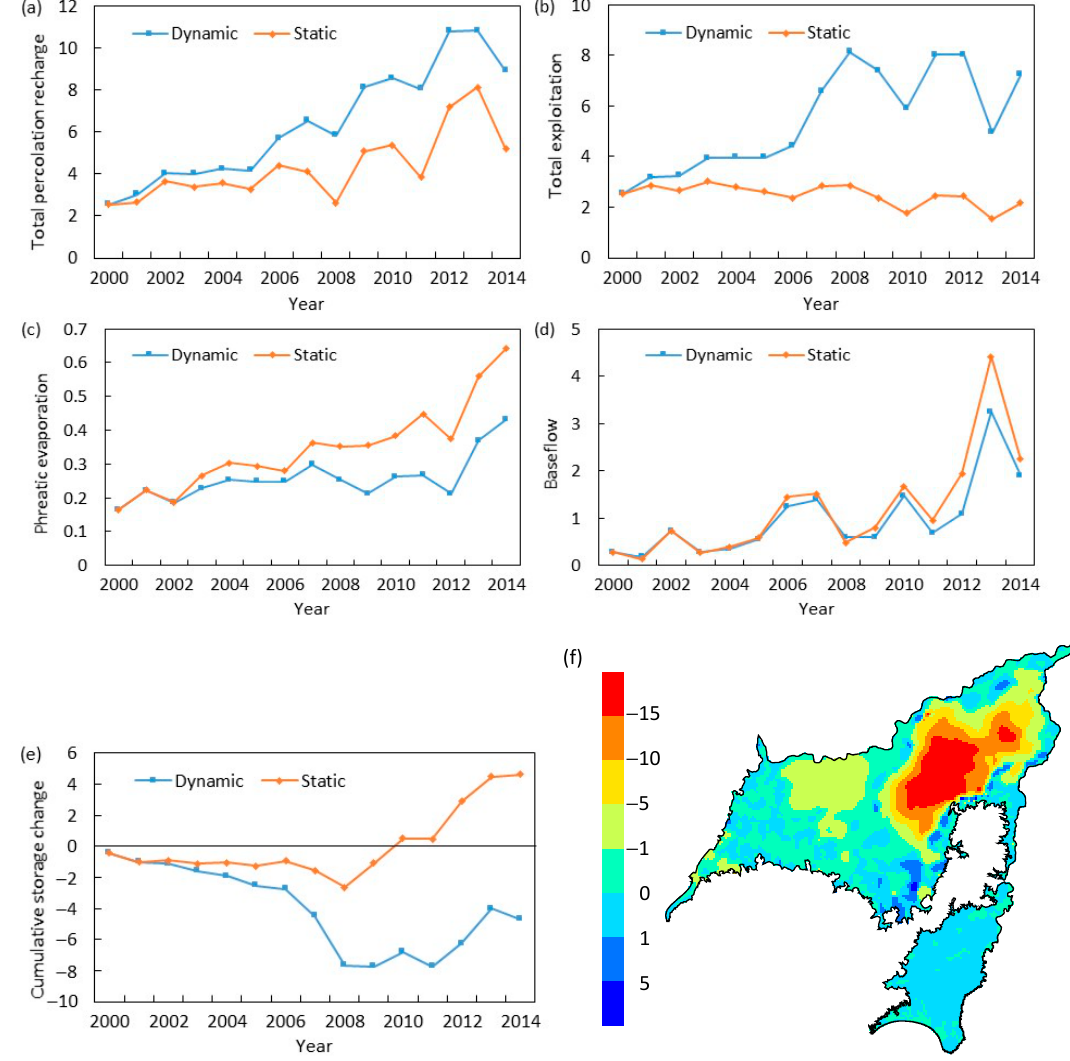
Figure 12. Comparisons of ( a ) total percolation recharge, ( b ) total exploitation, ( c ) phreatic evaporation, ( d ) baseflow, ( e ) cumulative storage change from 2000 to 2014 (unit: 10 9 m 3 ), and ( f ) difference in the groundwater level at the end of 2014 between the dynamic mode and the static mode (unit: